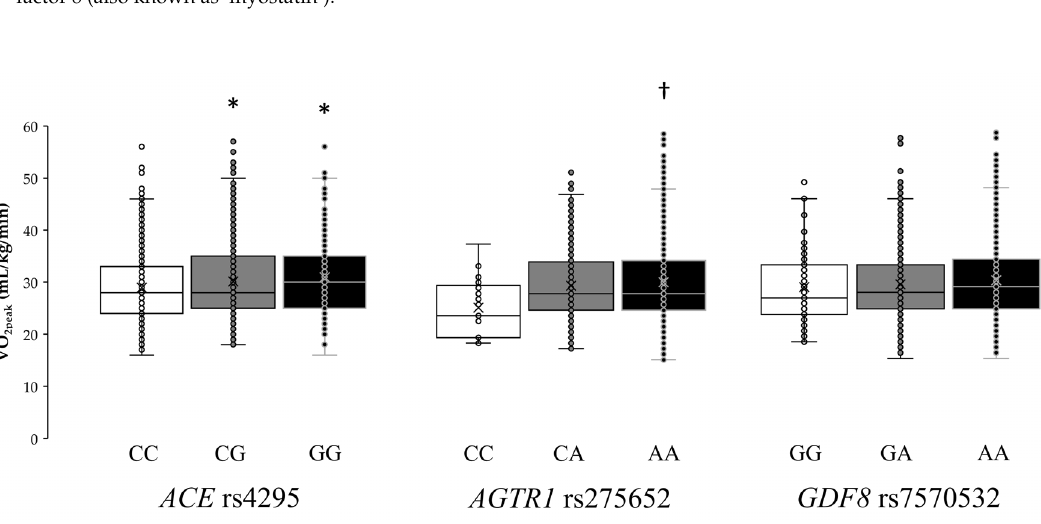
Figure 3. Box-and-whisker plots showing peak oxygen uptake (VO 2peak ) in the study participants according to genetic variations in the genes for angiotensin-converting enzyme ( ACE ; rs4295) , angiotensin II receptor type 1 ( AGTR1 ; rs275652), and growth di ff erentiation factor 8 ( GDF8, also known as ‘myostatin’; rs7570532). The lines in the box represent the first, second (median) and third quartiles, and the whiskers represent 1.5 × interquartile ranges. Each dot represents one individual within the specified genotype. (*) Depicts a statistically significant di ff erence from CC genotype in ACE rs4295 polymorphism at p < 0.05. ( † ) Depicts a statistically significant di ff erence from CC genotype in AGTR1 rs275652 polymorphism at p < 0.05.